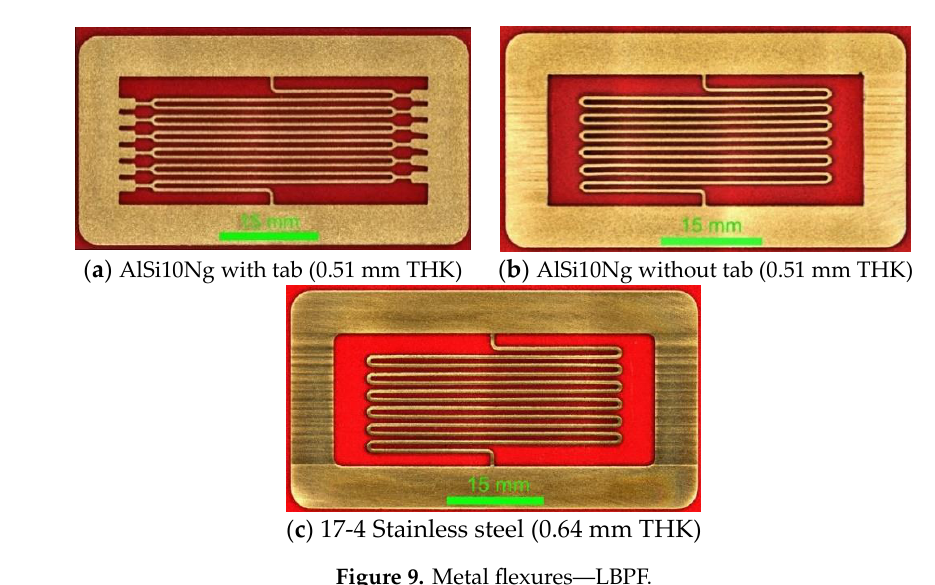
Figure 9. Metal flexures—LBPF. Table 3. Material properties of GR and HTL.